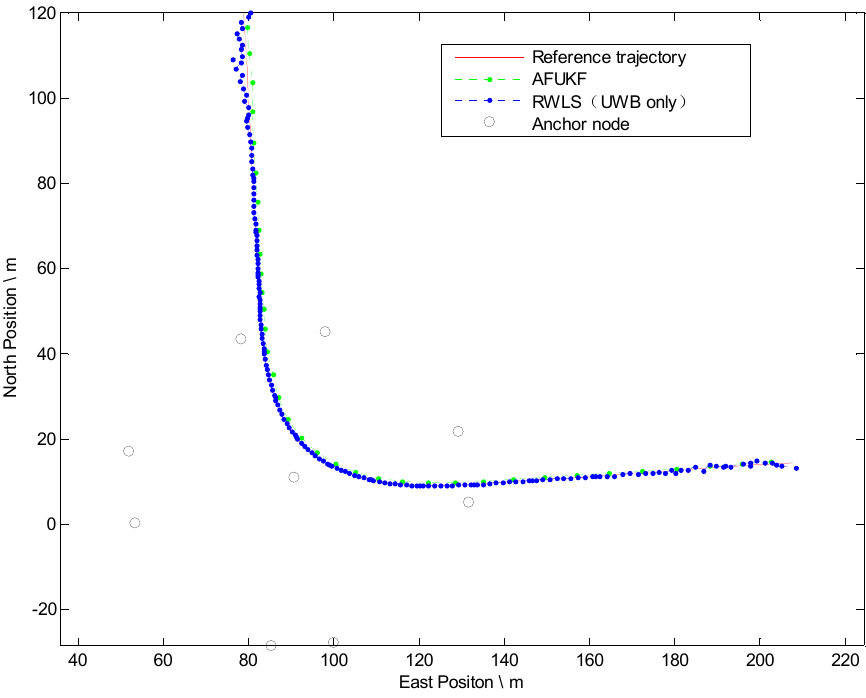
Figure 11. Positioning results in Trajectory IV (Left Turn).